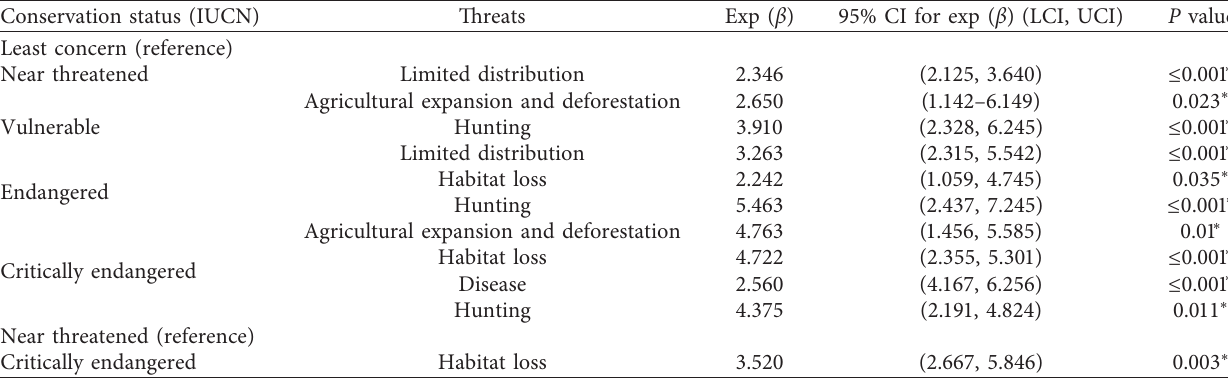
Table 1: Multinomial logistic model shows determinant factors of the conservation status of endemic mammals from the EA, taking least concern and then data deficient category as a reference.